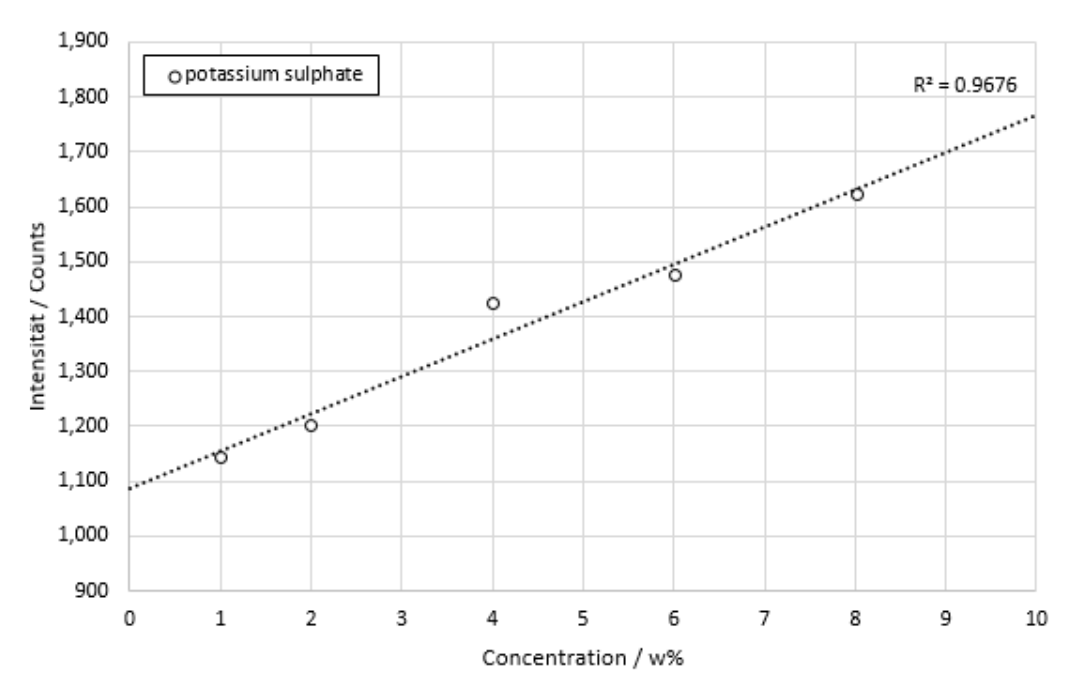
Figure 12. Concentration series of potassium sulphate dissolved in deionized water. The integration time is 100 ms. Each concentration was measured for about a time of 2 min.